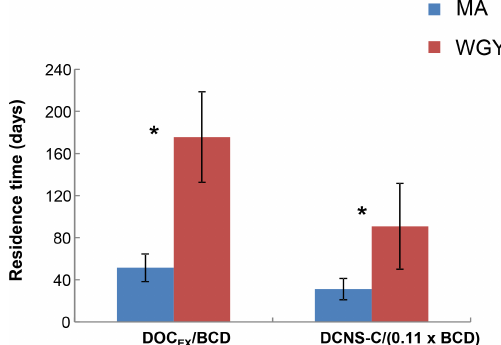
Figure 7. Residence time (days) of semi-labile DOC ( T r SL ) and DCNS-C ( T r DCNS-C ) for MA and WGY areas. ∗ T r SL and T r DCNS-C were statistically different between MA and WGY areas (Mann–Whitney test, p < 0 .